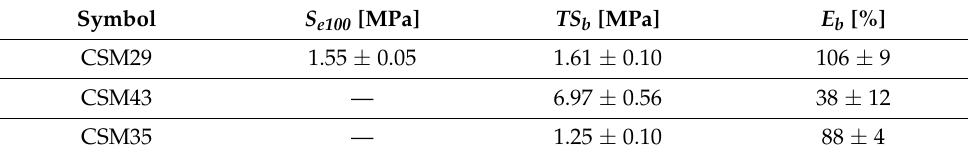
0.05 1.61 0.10 ± ± 0.56 ± — 1.25 0.10 ±